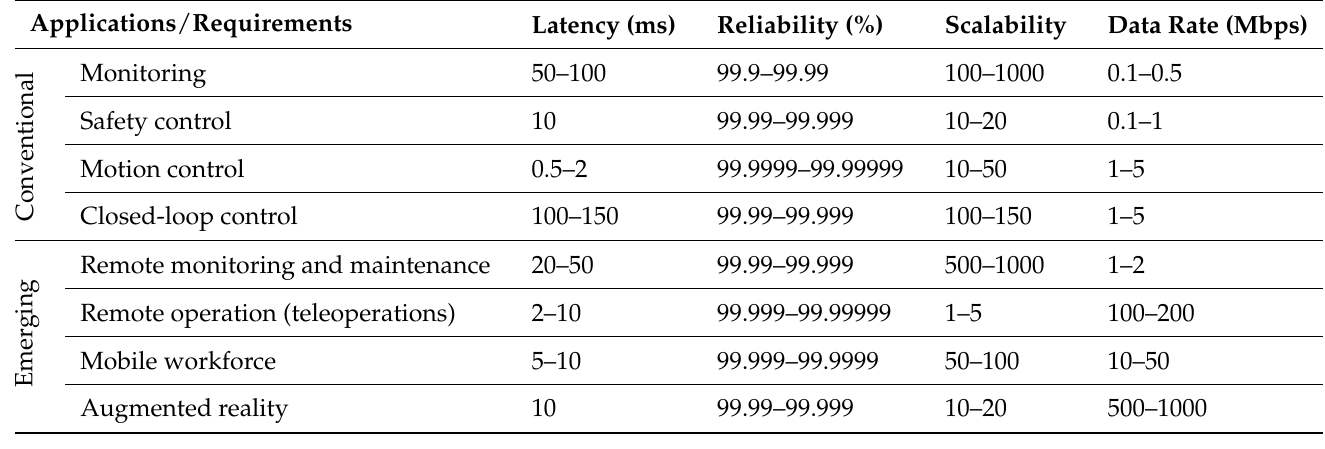
Table 1. Summary of the connectivity requirements for traditional IIoT and emerging tactile IIoT services.